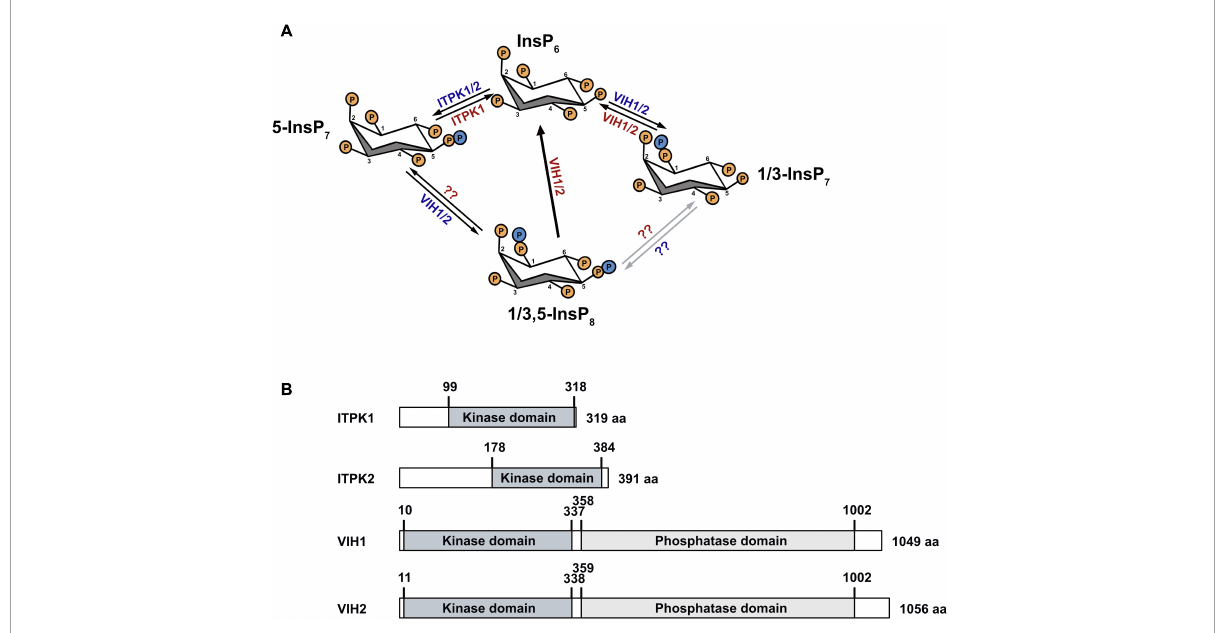
FIGURE1 Inositol pyrophosphate biosynthesis pathway in plants and protein architecture of kinases. (A) ITPK1/2 and VIH1/2 phosphorylate InsP6 to generate 5-InsP7 and 1-InsP7, respectively. Further, VIH1/2 use 5-InsP7 as substrate to generate InsP8. The isomer identity of InsP8 remains unresolved but presumably represents the 1,5 and/or the 3,5-InsP8 isomer. VIH1/2 are also able to dephosphorylate 1/3,5-InsP8 and 1/3-InsP7 to InsP6. At low adenylate charge, the ITPK1 kinase domain also catalyzes the reverse reaction from 5-InsP7 to InsP6 in the presence of ADP to locally generate ATP. The gray arrows and question marks denote alternative routes of 1/3-InsP7 and 1/3,5-InsP8 synthesis, and the responsible enzymes, respectively. (B) Schematic representation of ITPK1, ITPK2, VIH1 and VIH2 architectures. Kinase domains are shown in dark gray, phosphatase domains in light